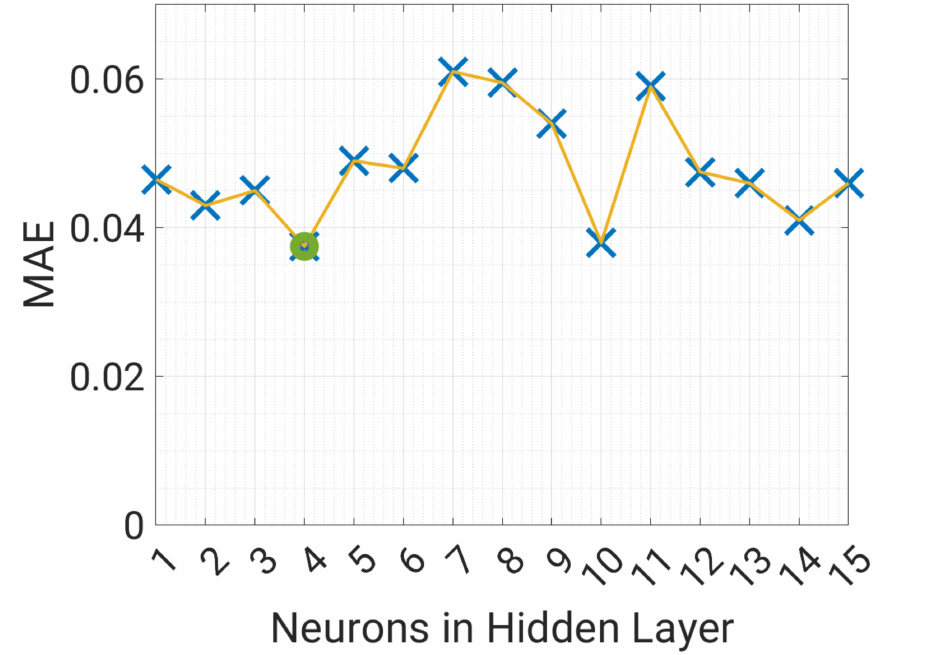
Figure 10. Selection of the number of neurons of the NN to predict